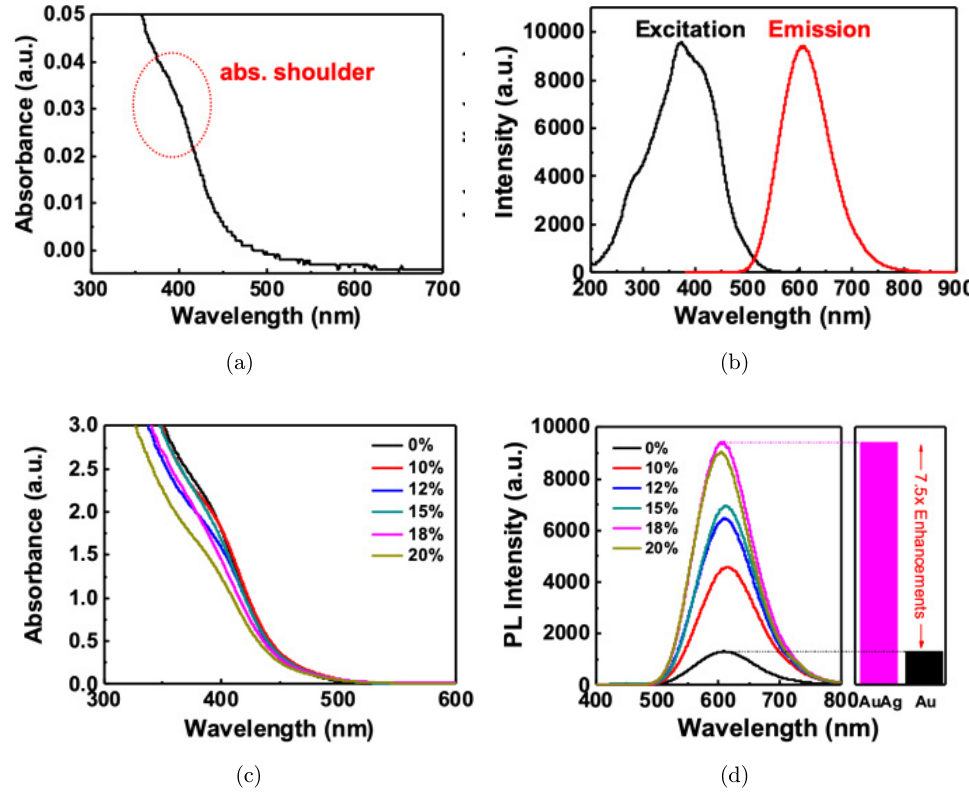
Fig. 1. Optical properties including (a) UV-Vis spectrum of freshly prepared GSH-protected AuAg NCs. The weak characteristic absorption shoulder can be found at (cid:1) 405 nm, (b) excitation and emission spectrum, there is a stokes-shift of 235 nm, (c) absorption spectra with varied silver doping ratio from 0 to 20%, there are no obvious di®erent between these curves and (d) °uorescence spectra under same concentration of di®erent doping scales, 7.5-fold °uorescence enhancement could be obtained when doping ratio is